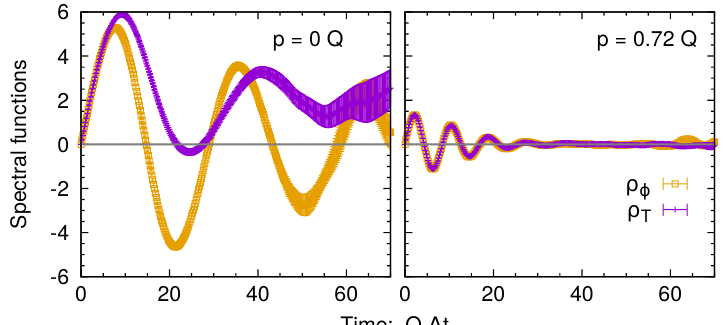
Figure 7 . The actual scalar and transverse spectral functions ρ φ and ρ T of the Glasma-like 2+1D theory for momenta p = 0 Q (left) and p = 0 . 72 Q (right) as functions of relative time ∆ t . Different from the dotted spectral function ˙ ρ in figure 6, ρ is seen to oscillate around a non-zero value in T T the left